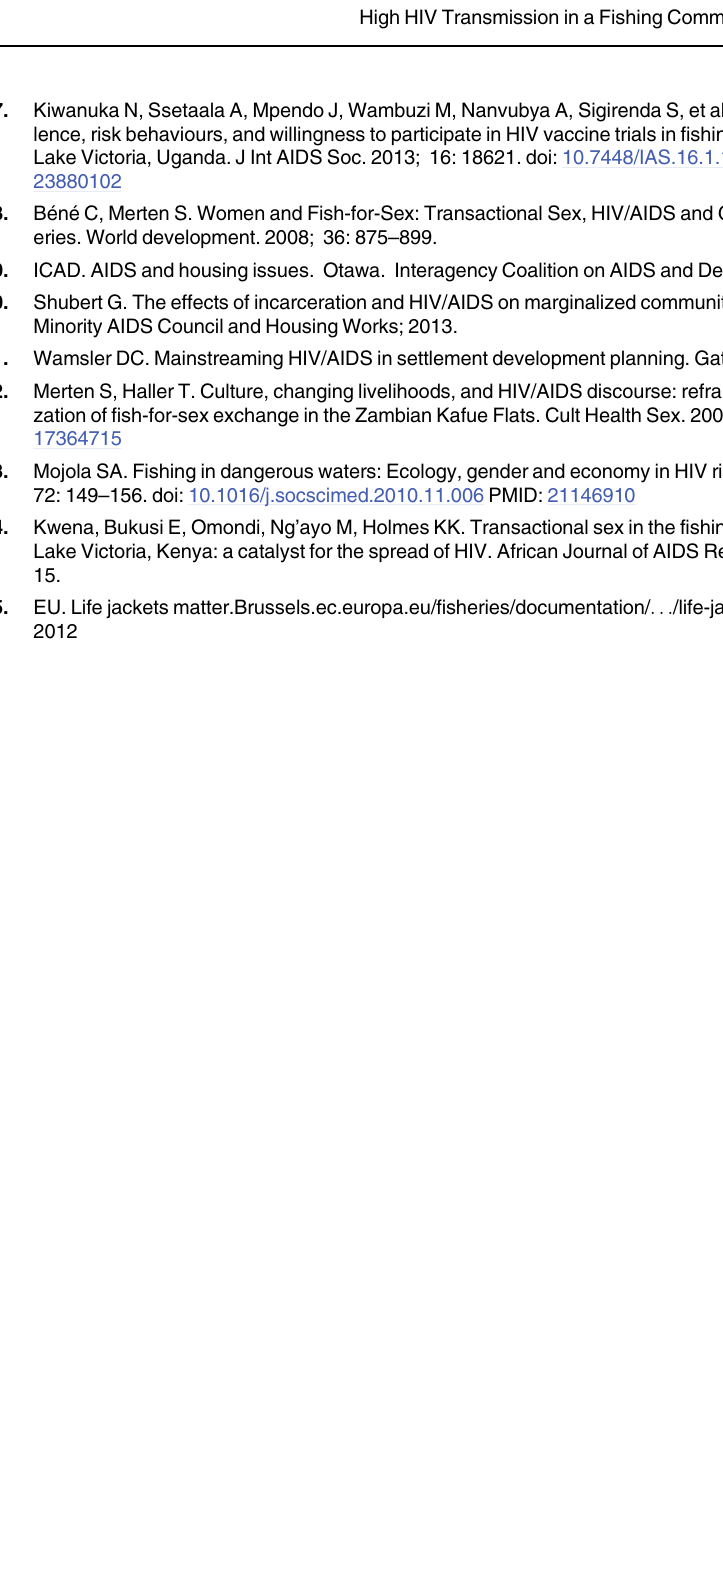
PLOS ONE | DOI:10.1371/journal.pone.0132740 August 26,